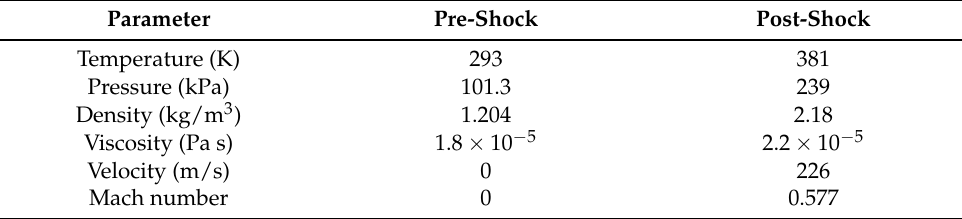
Table 1. Airflow